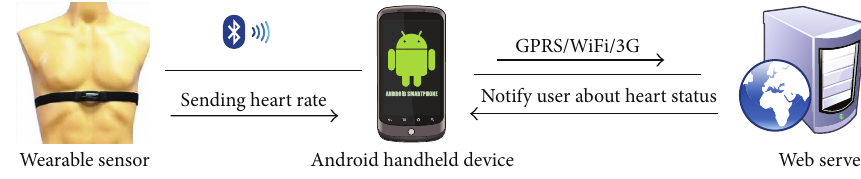
Figure 1: System architecture for remote patient monitoring system.